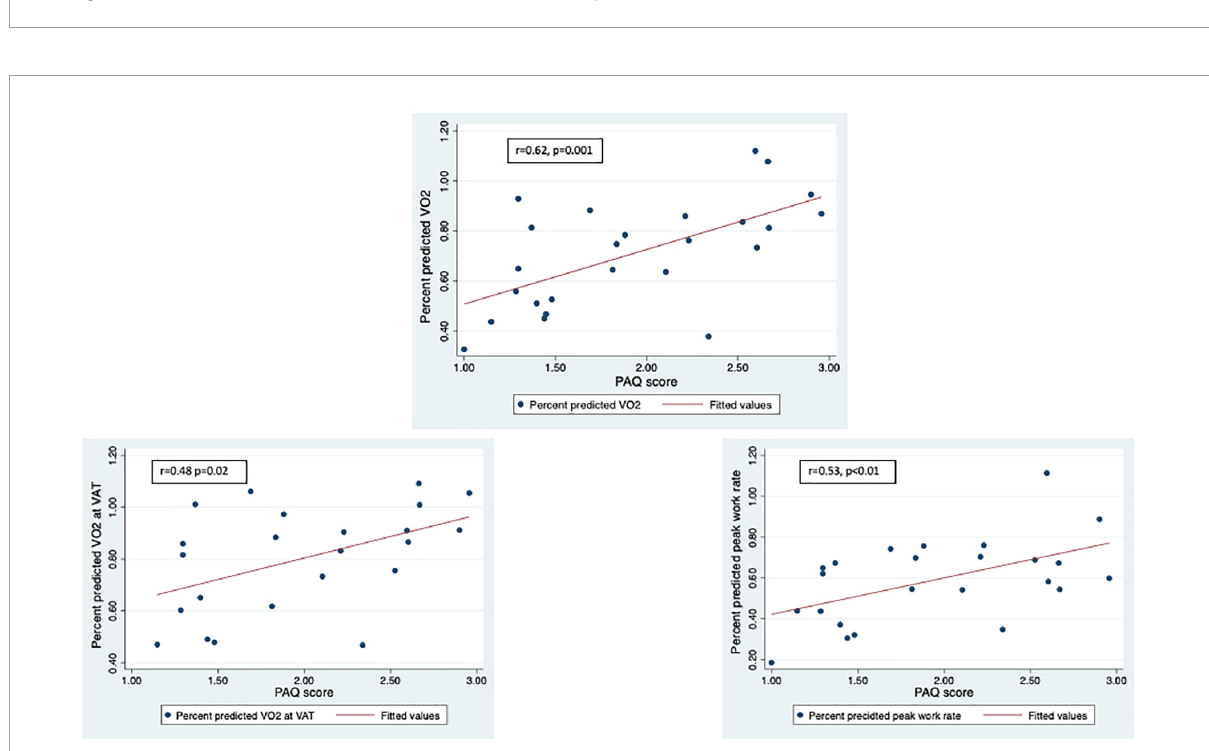
FIGURE3 LLMZ, D-HGZ, and PAQ score were associated with percent predicted peak VO 2 , percent predicted VO 2 at VAT, and percent predicted work. This figure demonstrates the associations between PAQ score and CPET